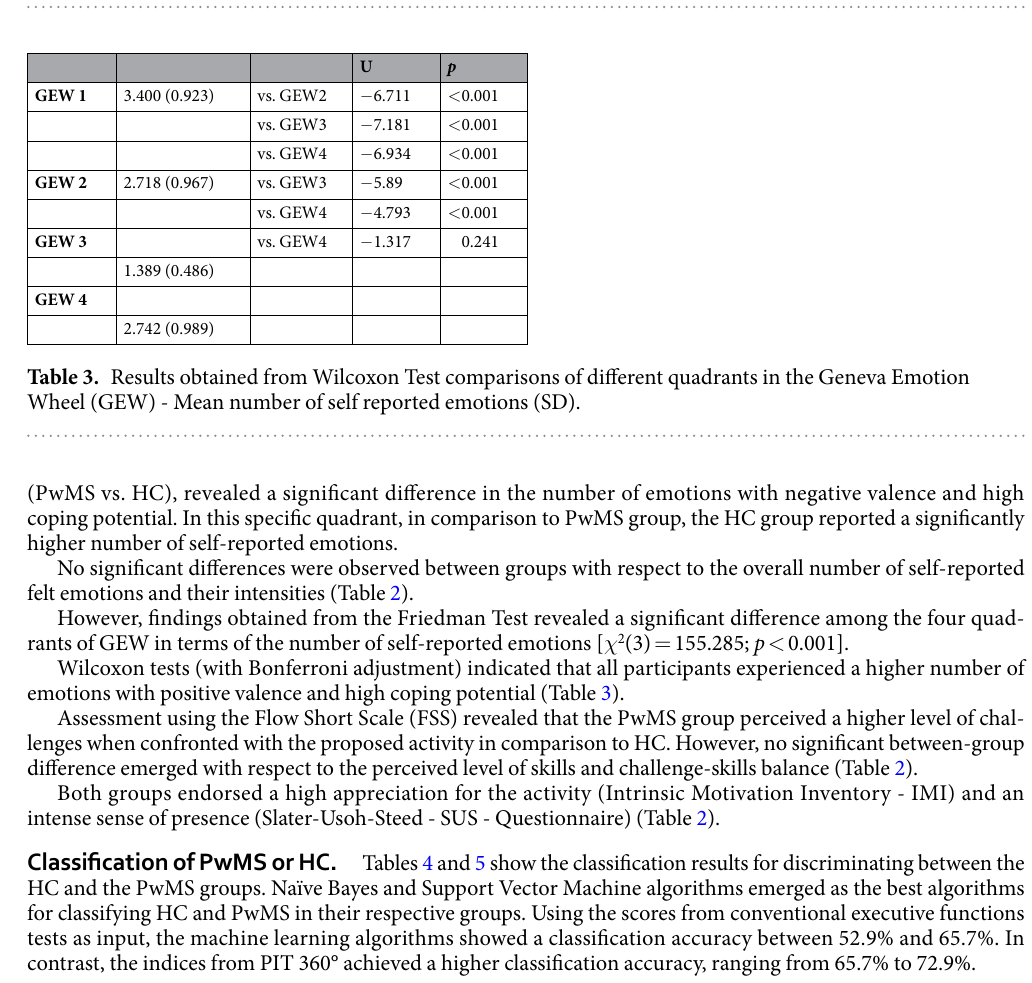
Table 2. Scores obtained from the user experience assessment for PwMS and HC. Data are shown as Means (M) and Standard Deviations (SD). Abbreviations: PwMS group, People with Multiple Sclerosis; HC group, Healthy Control; M, Mean; SD, Standard Deviation; GEW, Geneva Emotion Wheel; FSS, Flow Short Scale; IMI, Intrinsic Motivation Inventory; SUS, Slater-Usoh-Steed. a One participant in the “HC group” was excluded from the analyses of GEW data because of problems in data collection.